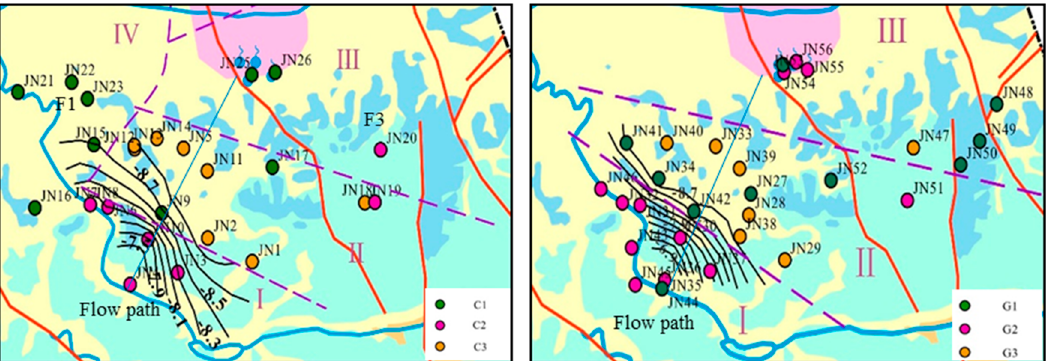
Figure 9. Distribution of groundwater samples based on the cluster analysis in May ( left ) and October ( right ) (black line is the isoline based on the δ 18 O values of groundwater samples; the C1, C2, and C2 in May and G1, G2, and G3 in October are the clusters from the hierarchical cluster